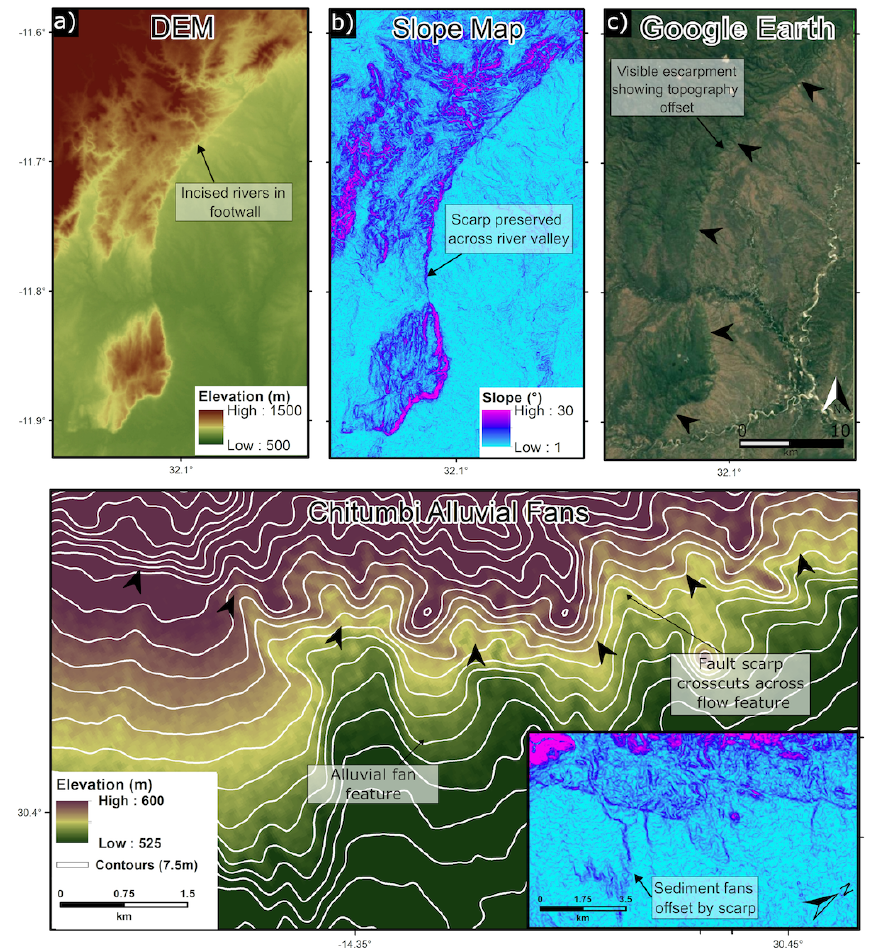
Figure 7. Example of active fault indicators on the Kabungo Fault. (a–c) Slope, DEM, and Google earth maps (© Google Earth) show the pronounced Kabungo fault escarpment, with a steep (30 ◦ ) scarp. The scarp is preserved across the river channel, indicating a recent offset such that the channel has not had time to fully respond after uplift. (d) Contour map of alluvial fans offset by the Chitumbi Fault (slope map of the same area is